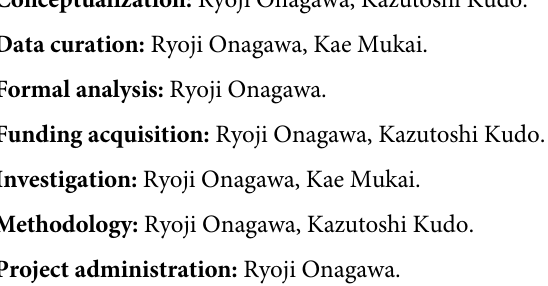
S3 Table. Mean of ⊿ Ztwo-ave (corresponding to Fig 4B). S4 Table. Mean of Absolute ⊿ Ztwo-one (corresponding to Fig 5A). S5 Table. Mean of integrated value (corresponding to Fig